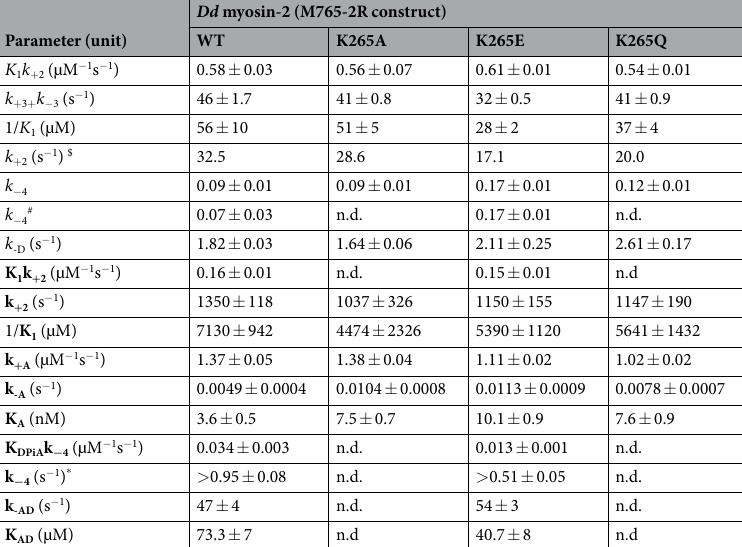
Dd myosin-2 (M765-2R construct)